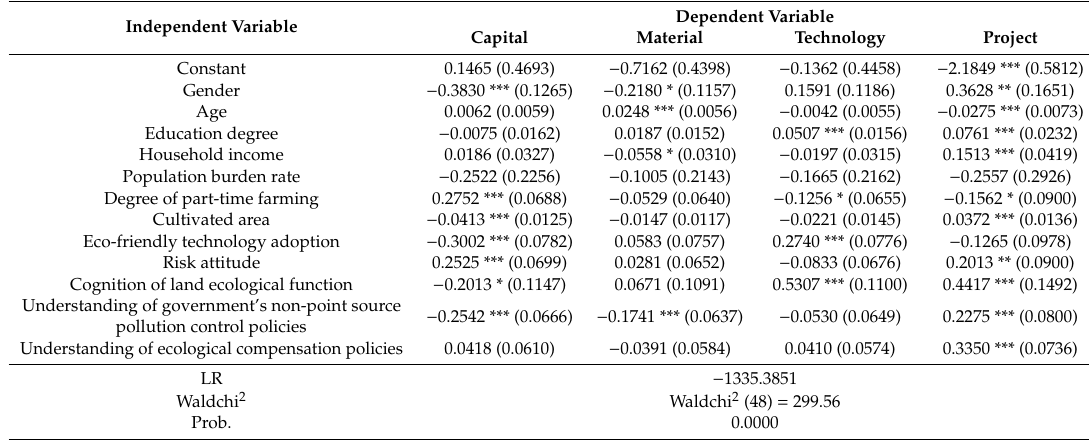
Table 4. Regression results of multivariate probit